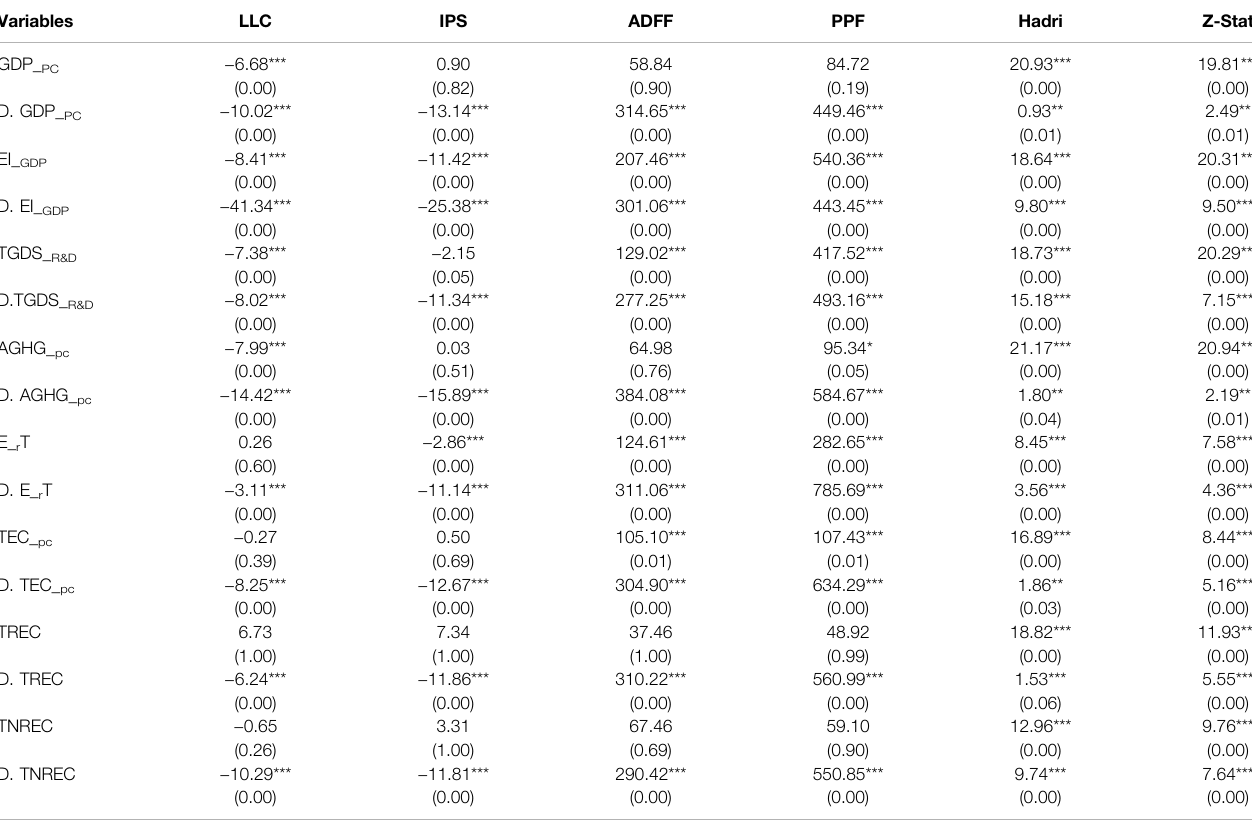
TABLE 4 | Results of the fi rst-generation unit root tests.